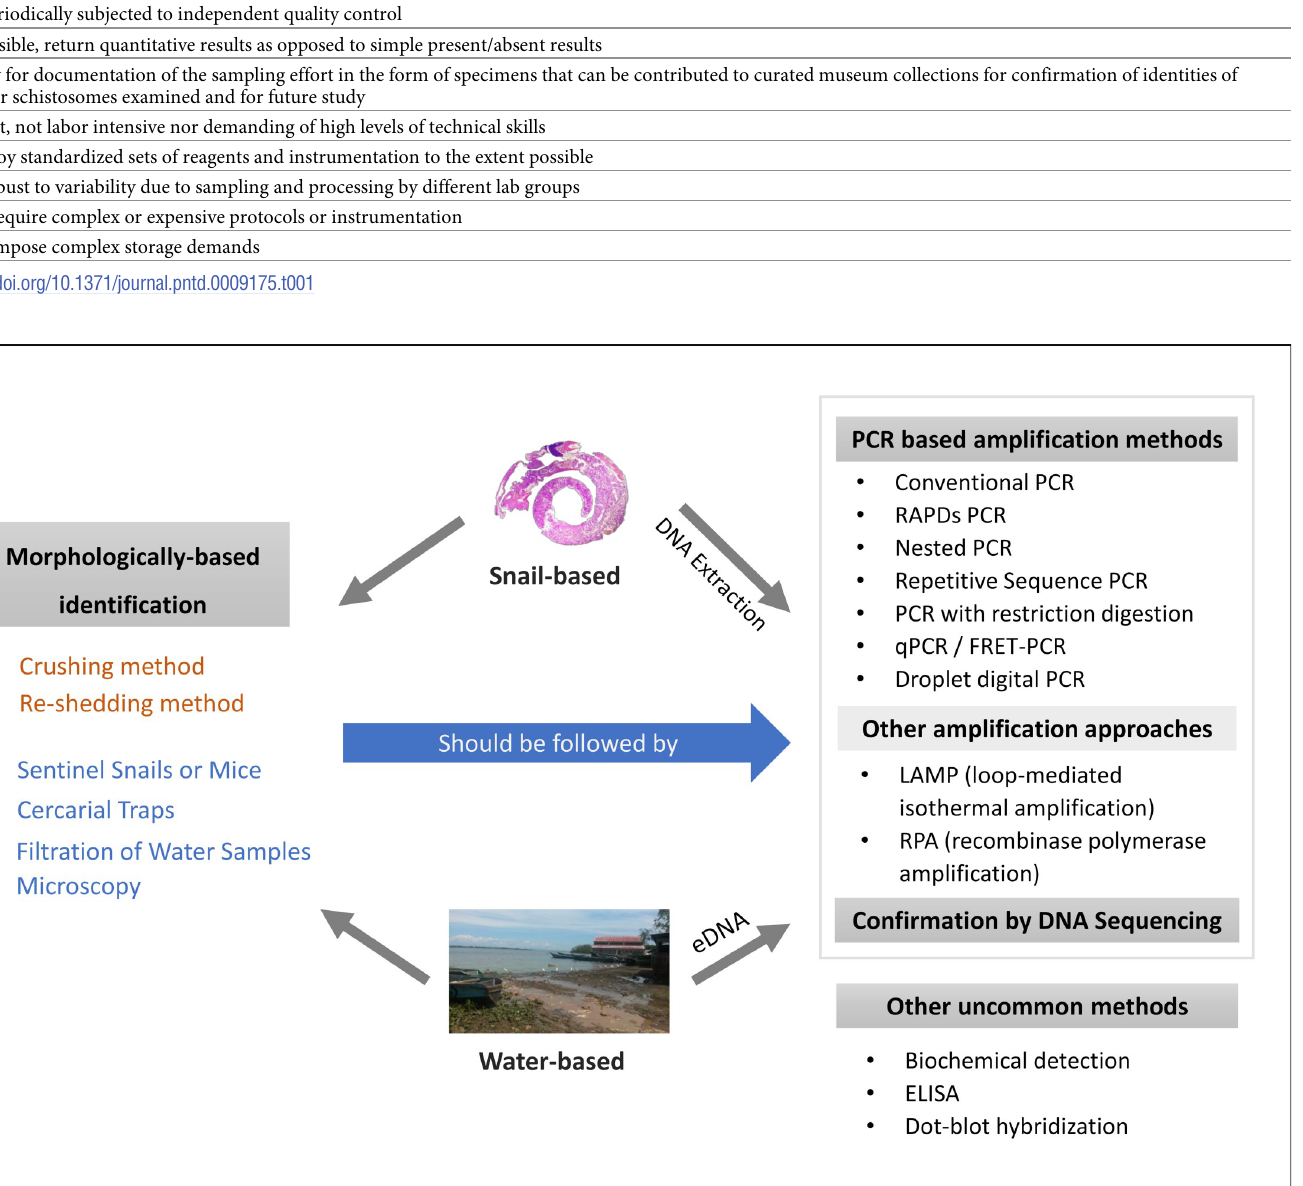
PLOS NeglectedTropical Diseases | https://doi.org/10.1371/journal.pntd.0009175 March 24,